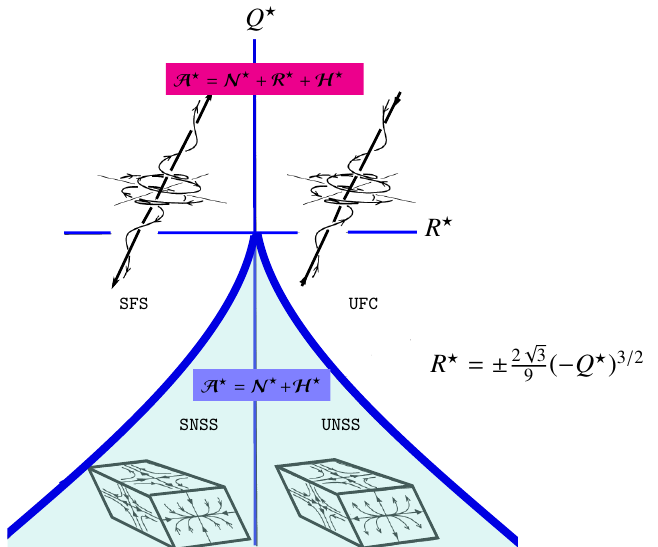
Figure 2. Classification of local three-dimensional streamlines into non-degenerate topologies in the Q (cid:63) − R (cid:63) plane for the incompressible turbulence [41]. The curved solid lines are the discriminant, ∆ A (cid:63) ,